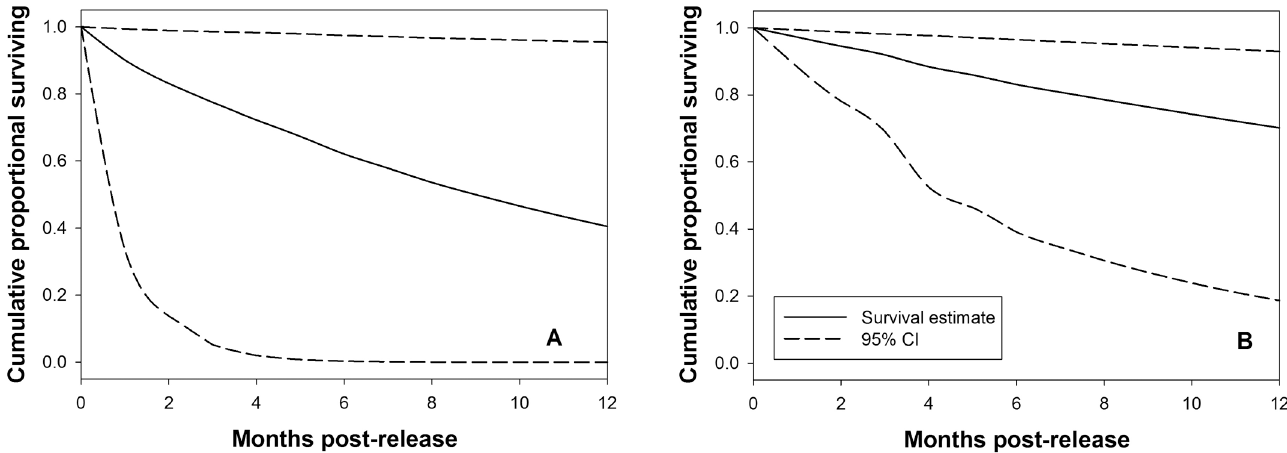
Fig 2. Survival rate estimates from MARK of reintroduced salamanders over one year. Salamanders reintroduced to the Heihe River (A) had a lower annual survival estimate than salamanders reintroduced to the Donghe River